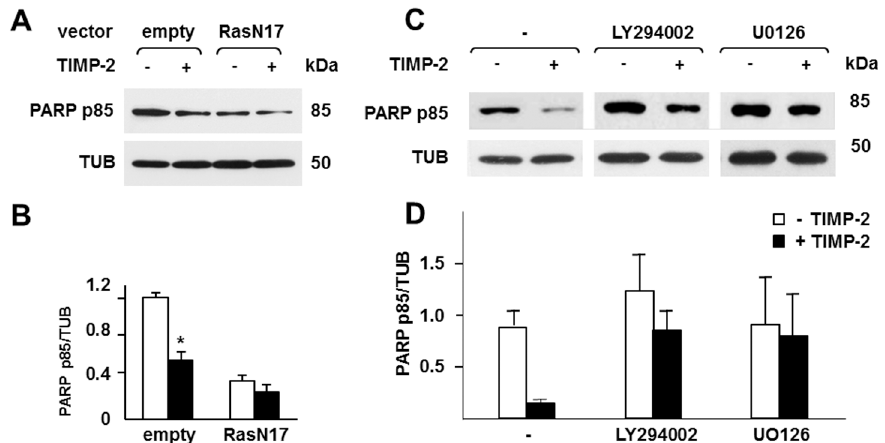
Fig 8. TIMP-2 – MT1-MMP interaction induces prosurvival signaling through Ras activation and both the ERK1/2 and AKT pathways. A . Western blotting analysis of PARP degradation (PARP p85) in MT1-MMP-expressing Tet-Off MCF-7 cells transiently transfected with RasN17 cDNA or control empty vector, grown in serum-free medium in the presence (+) or absence (-) of TIMP-2 (100 ng/ml) for 7 days. B . Densitometric analysis. C . Western blotting analysis of PARP degradation in MT1-MMP-expressing Tet-Off MCF-7 cells grown for 7 days in serum-free medium with LY294002 (10 μ M) or U0126 (10 μ M) or with control vehicle (-) in the presence (+) or absence (-) of TIMP-2 (100 ng/ml). D . Densitometric analysis. Beta tubulin (TUB) is shown as a loading control. * , p (cid:1) 0.05, + TIMP-2 vs . the corresponding – TIMP-2 sample. This experiment was repeated twice with comparable results.